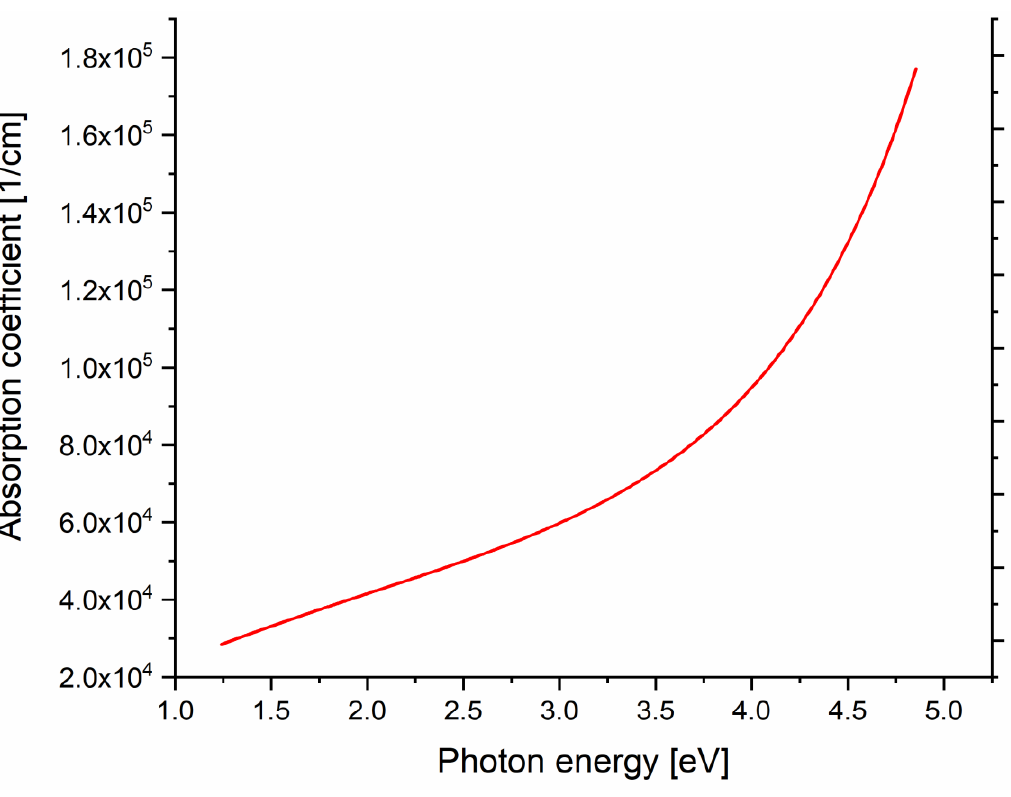
Figure 11. Absorption coefficient against photon energy for RGO films.